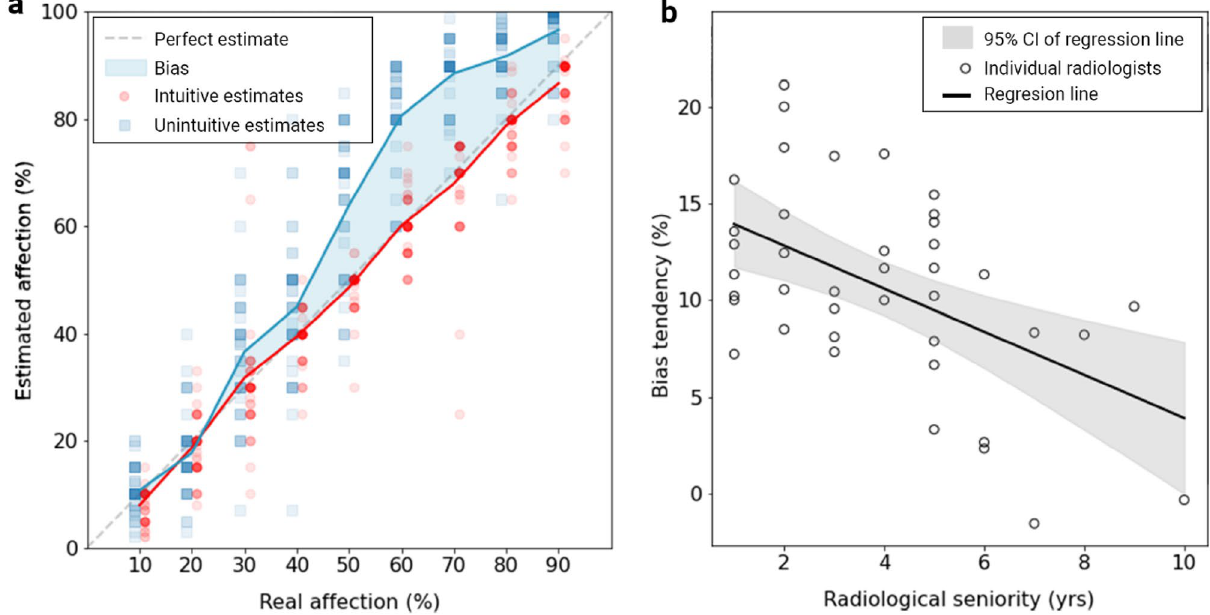
Figure 3. COVID-19 involvement overestimation across synthetic cases and radiological seniority. ( a ) Estimated involvement distribution for 18 synthetic cases. The estimates tend to diverge for the higher involvement percentages. ( b ) The bias tendency (mean difference in the overestimation) as a function of radiological seniority, using simple linear